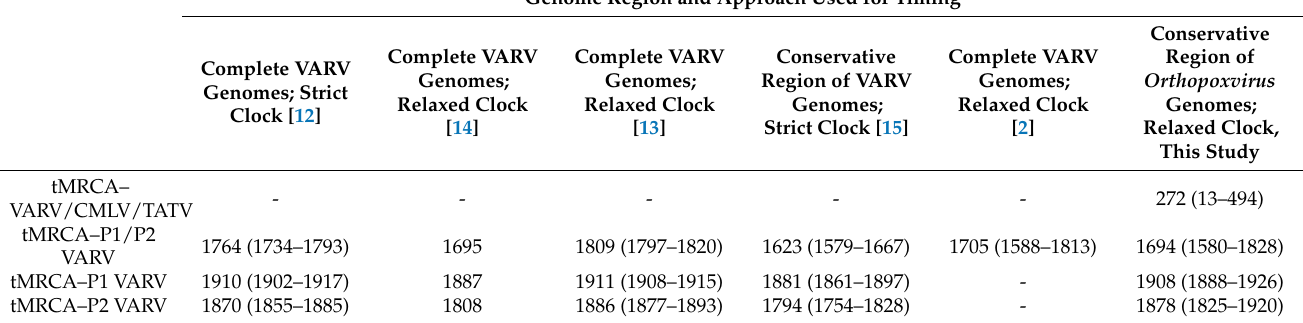
Table 2. Comparison of the time to the most recent common ancestor (tMRCA) of various orthopoxvirus clades with previously published